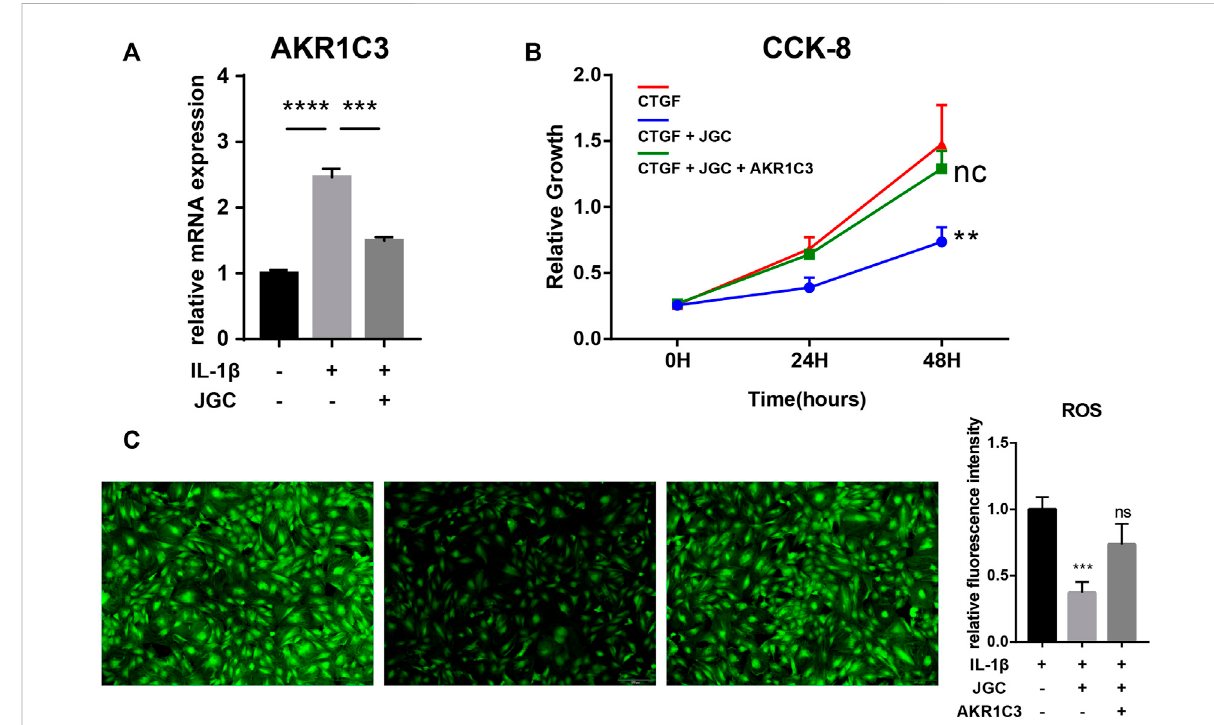
FIGURE 6 Rescue experiments of AKR1C3. (A) PCR showing that AKR1C3 is inhibited by JGC. (B) CCK-8 assay showing that AKR1C3 overexpression attenuates the JGC-mediated inhibition of cell proliferation. (C) ROS staining showing that AKR1C3 overexpression counteracts the anti- in fl ammatory effect of